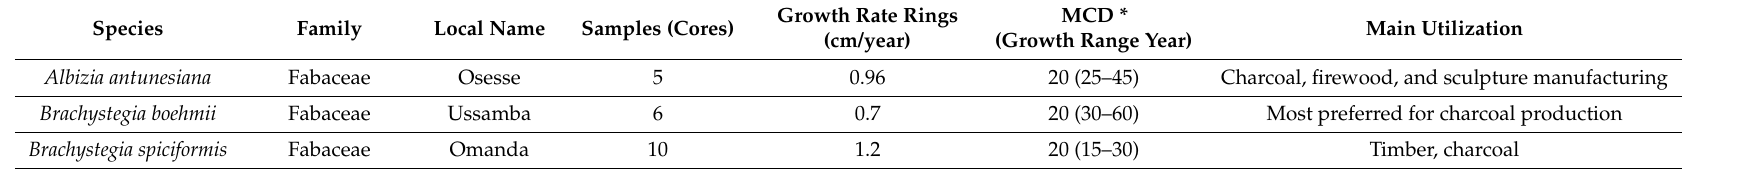
Table 4. Growth rate rings of the species investigated.